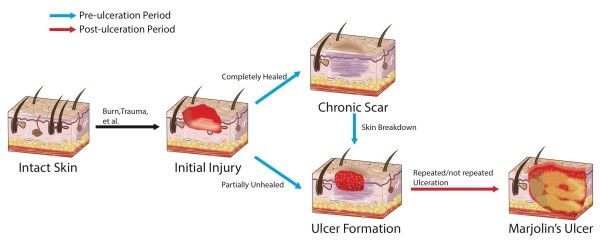
Various paths to malignancy during the latency period. Ulcer formation is a key step between initial injury and final malignant transformation.